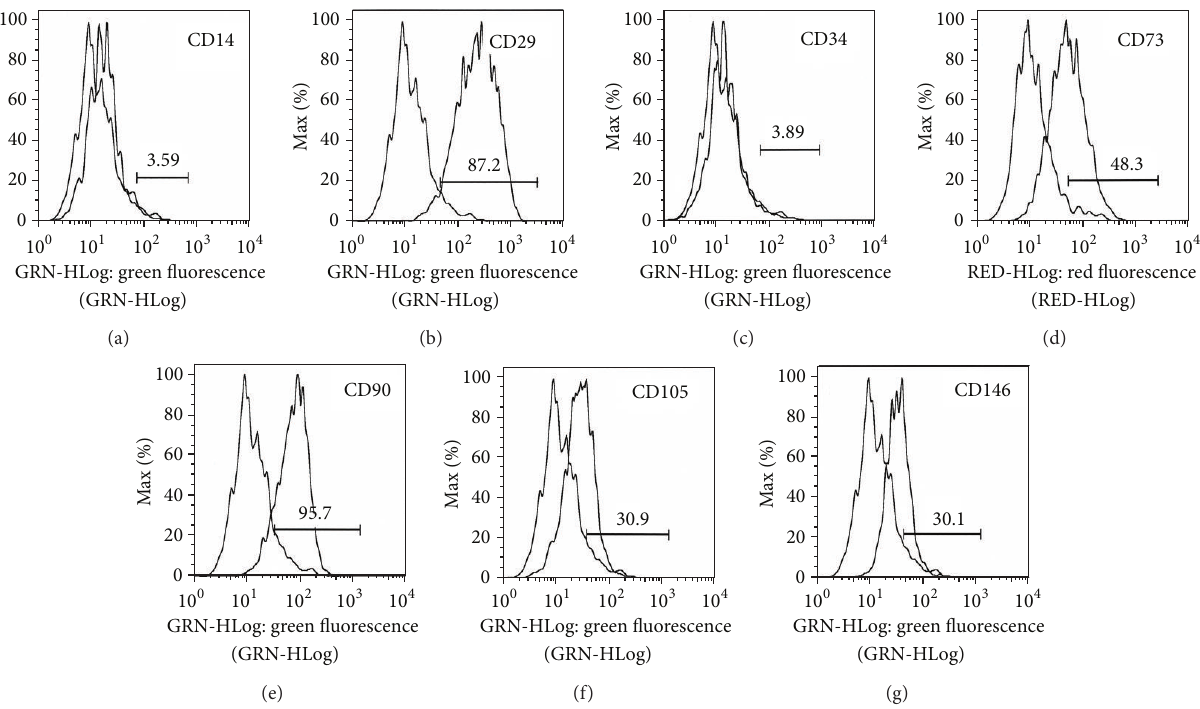
Figure 2: Flow cytometry histograms showed the DPSCs surface marker expressions after 0.4 T SMF exposure. Unstained control cells and cells stained with antibodies against the surface proteins were overlapped. Brackets indicate the positive cell populations in percent.